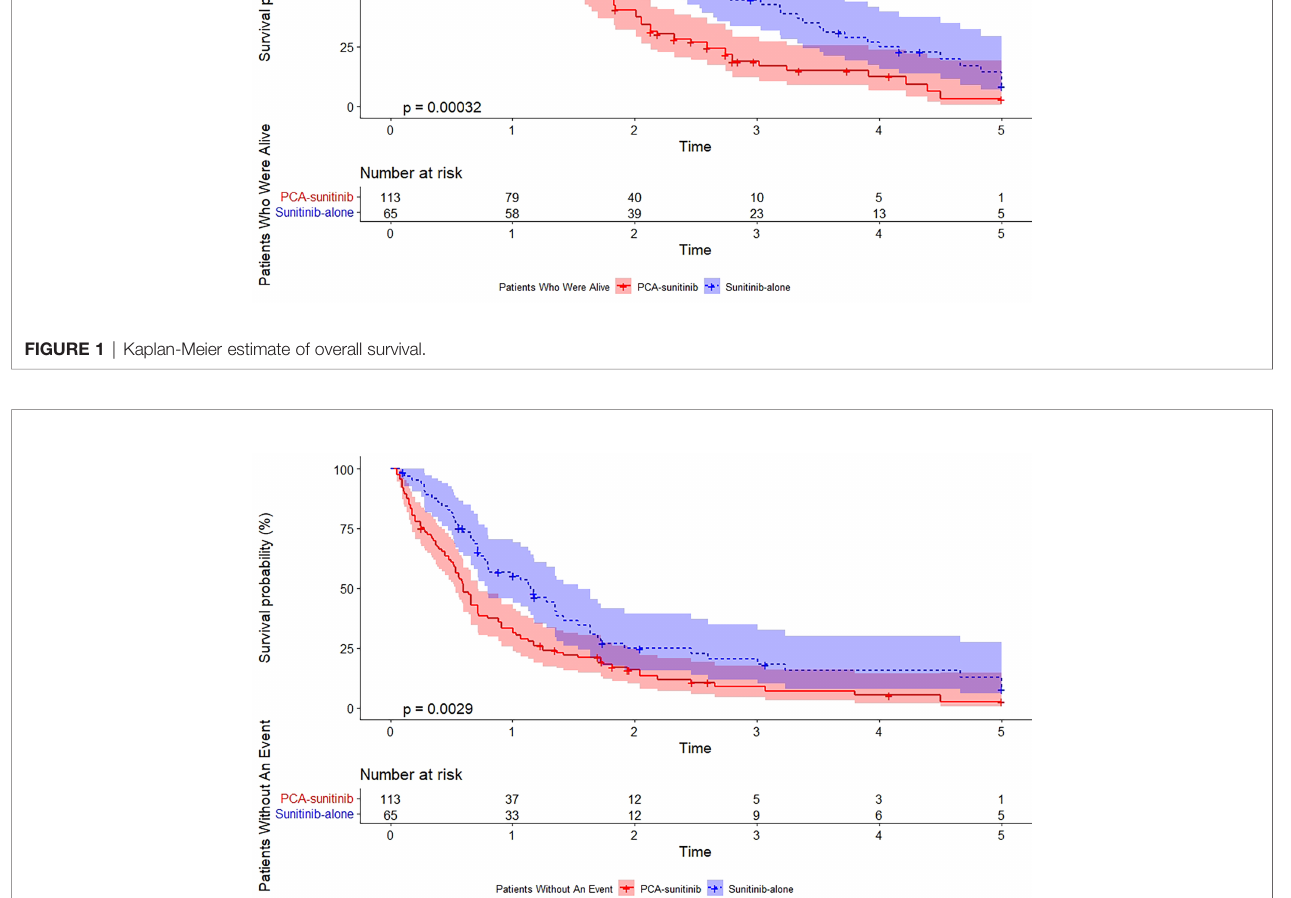
FIGURE 2 | Kaplan-Meier estimate of progression-free survival.